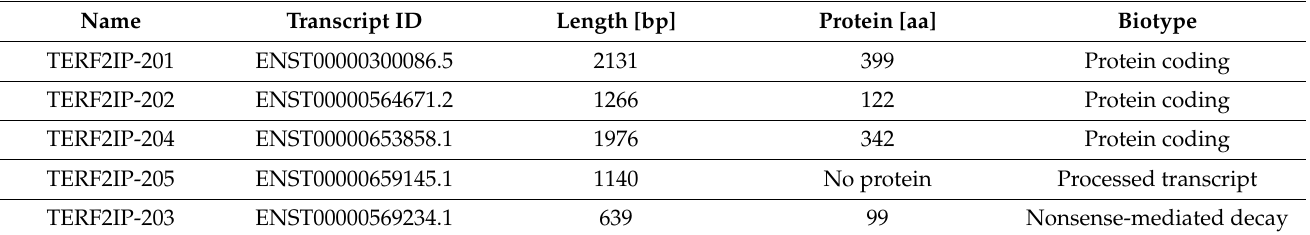
Table 1. RAP1 splicing variants (Ensembl GRCh37 release 104 - May 2021 ©